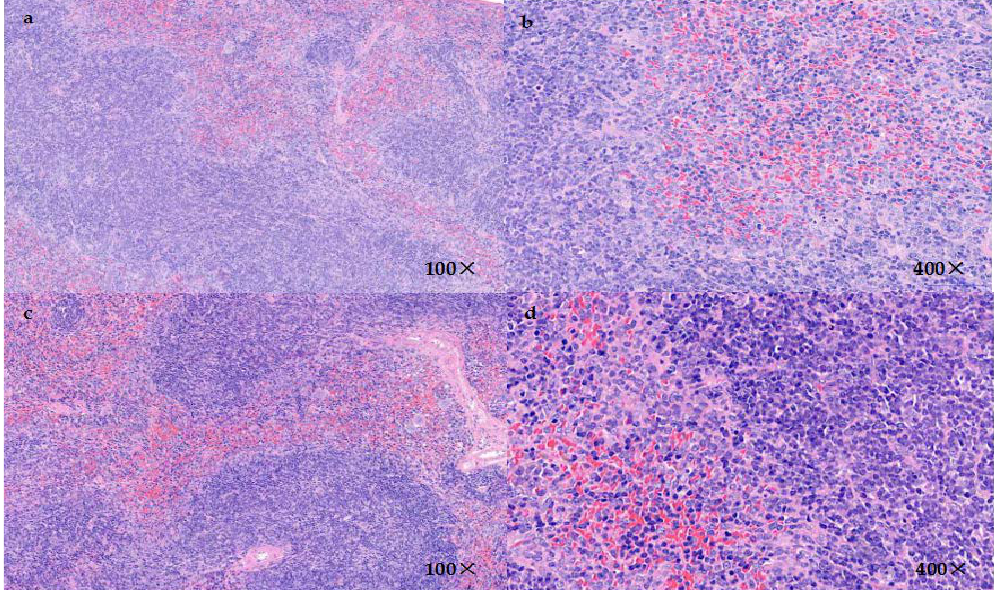
Figure 4. Pathological sections of spleen tissues from mice. ( a ) control group (magnification 100×); ( b ) control group(magnification 400×); ( c ) experimental group(magnification 100×); ( d ) experimental group(magnification 400×).